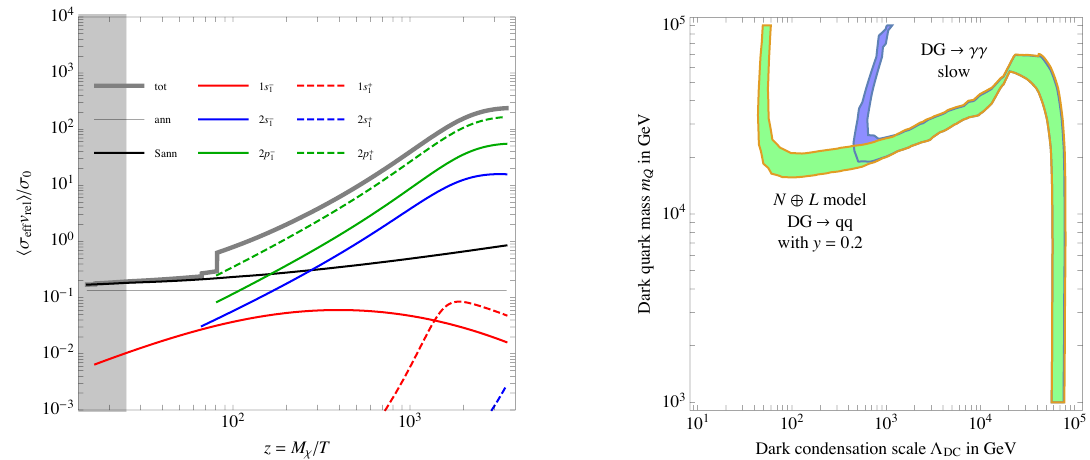
Left: thermally = 10 TeV Q